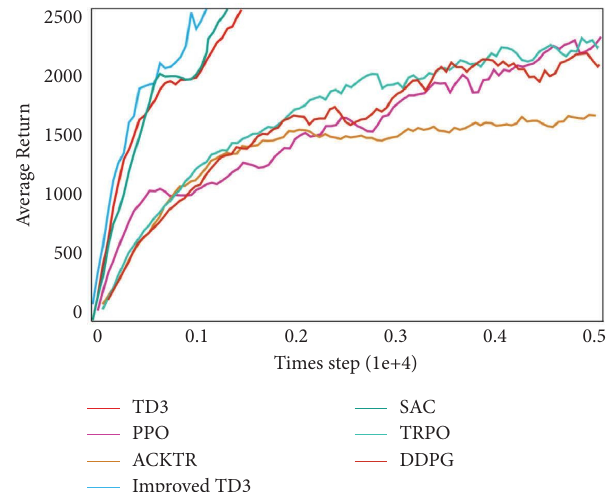
Figure 7: Comparison of initial convergence speed using seven diferent DRL methods.